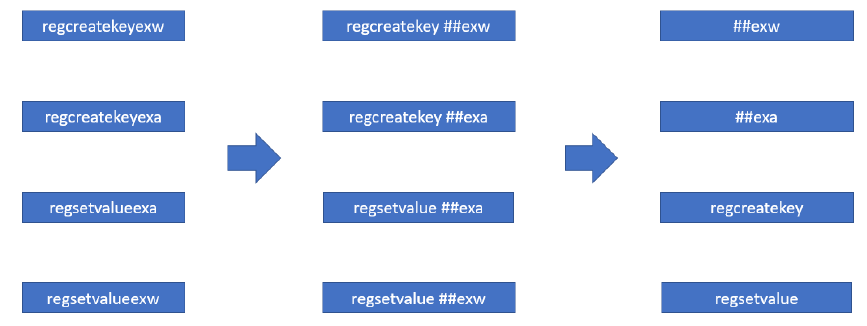
Figure 7. Word splitting process.